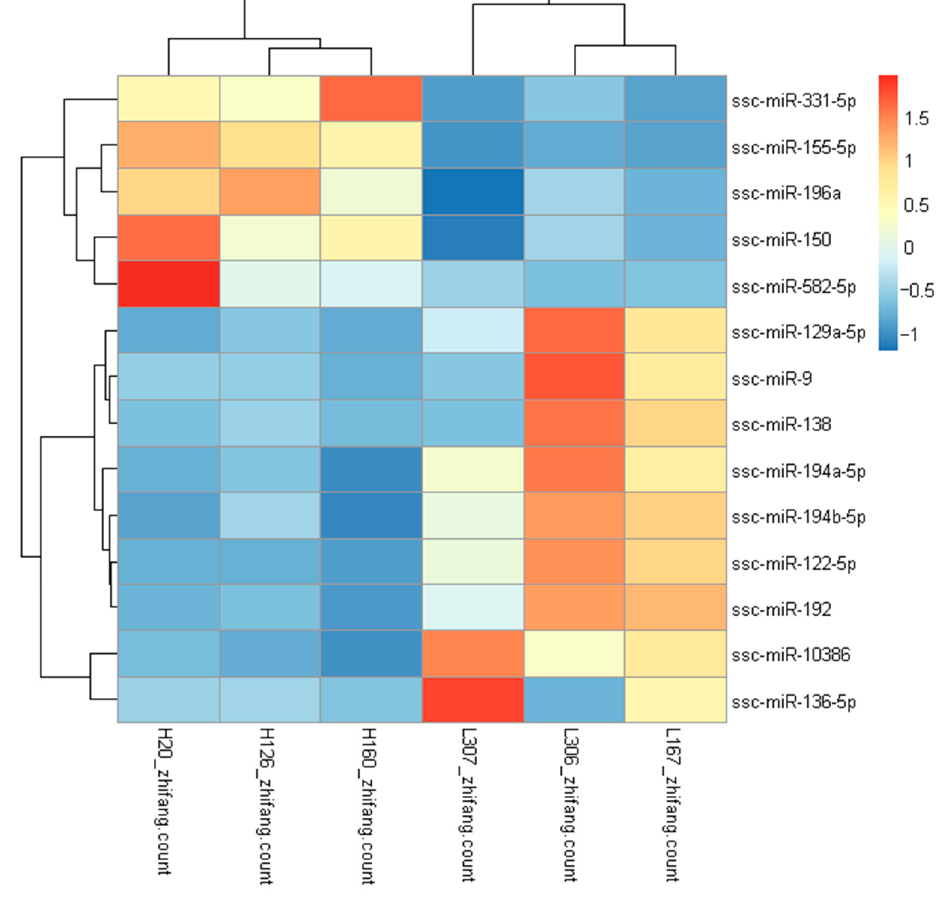
Figure 3. Hierarchically cluster heat map of DEMs. Red represents up-DEMs in adipose tissue, and blue represents down-DEMs in adipose tissue. Color intensity represents the degree of regulation (up- or down-regulation).